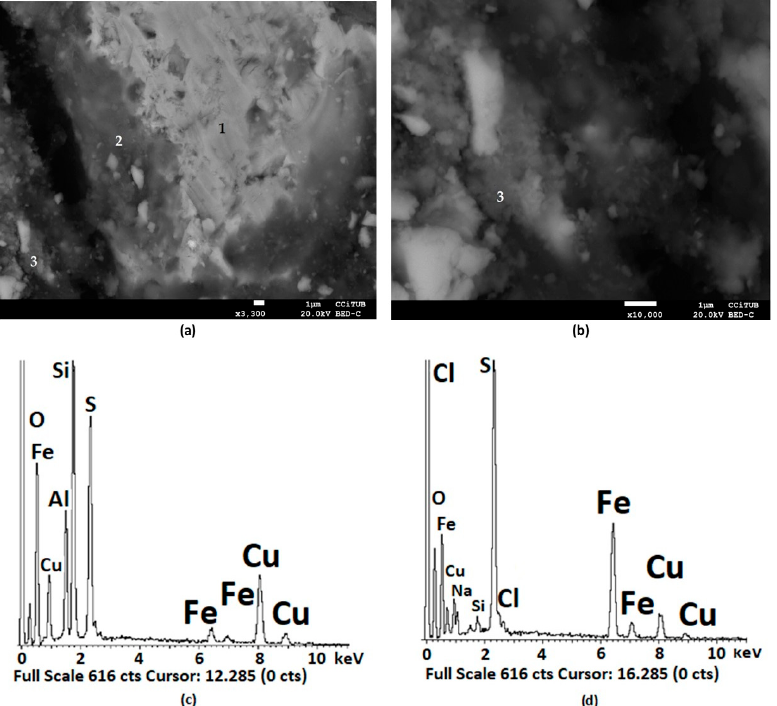
Figure 13. SEM images ( a , b ) and EDS analysis of chalcopyrite (1) and reaction products, such as CuSO 4 (2) (EDS in ( c )) and NaFe 3 (SO 4 ) 2 (OH) 6 (3) (EDS in ( d )), products of the pretreatment of chalcopyrite mineral with 15 kg/t of H 2 SO 4 , 25 kg/t of NaCl, and 15 days of curing time at room temperature. In ( a ) at a magnification of ×3.300 and ( b ) at ×10.000.